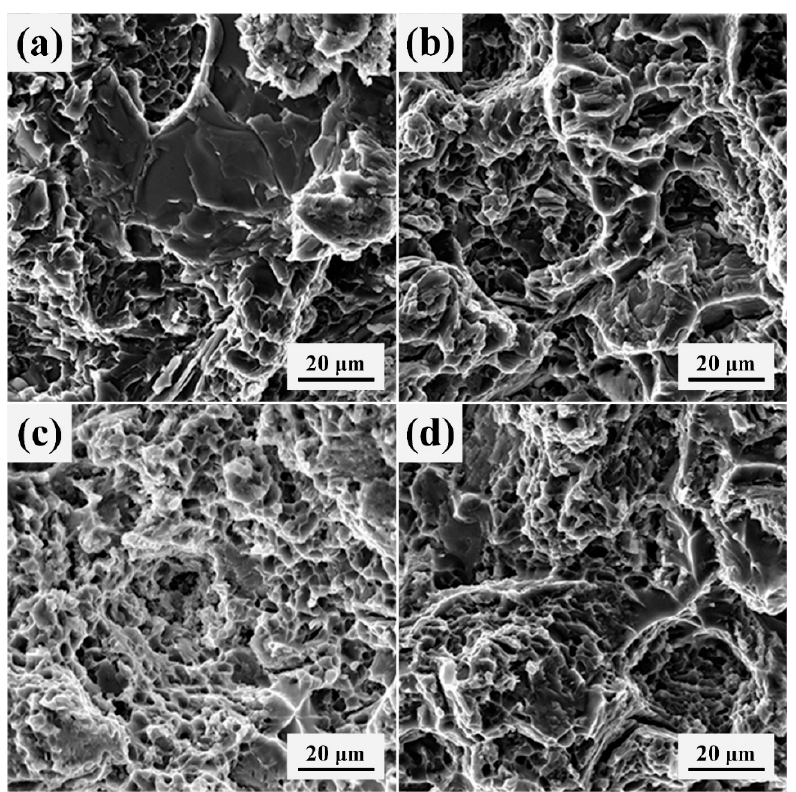
Figure 5. Tensile fracture morphology of ( a ) as-cast alloy GC, ST6 treatment; ( b ) alloy GC; ( c ) alloy SSDC; ( d ) alloy DC. SSDC; ( d ) alloy